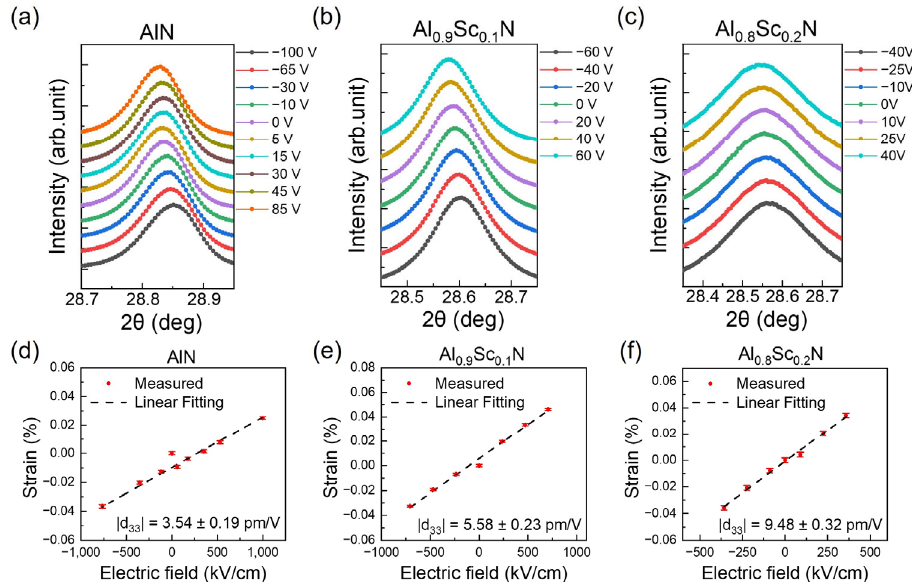
Figure 5. Synchrotron XRD curves of ( a ) AlN, ( b ) Al 0.9 Sc 0.1 N, ( c ) Al 0.8 Sc 0.2 N under different applied voltages V; Electric field E dependence of longitudinal strains of ( d ) AlN, ( e ) Al 0.9 Sc 0.1 N, ( f ) Al 0.8 Sc 0.2 N derived from synchrotron XRD peaks. The data from the standard PDF cards for AlN (No. 00 ‐ 025 ‐ 1133) are referred.